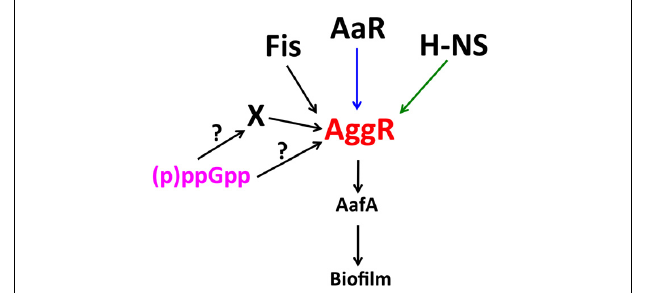
FIGURE 7 | Diagram showing the regulatory cascade influencing AggR expression. AggR is a key virulence regulator in EAEC. Downstream-regulated virulence factors include the AafA pilin subunit. FIS and H-NS proteins respectively induce and repress aggR transcription (black and green arrows, respectively). AaR protein post-transcriptionally represses AggR protein expression (blue arrow). We show in this work that the (p)ppGpp alarmone is a key factor regulating either directly or indirectly expression of aggR and AggR-activated